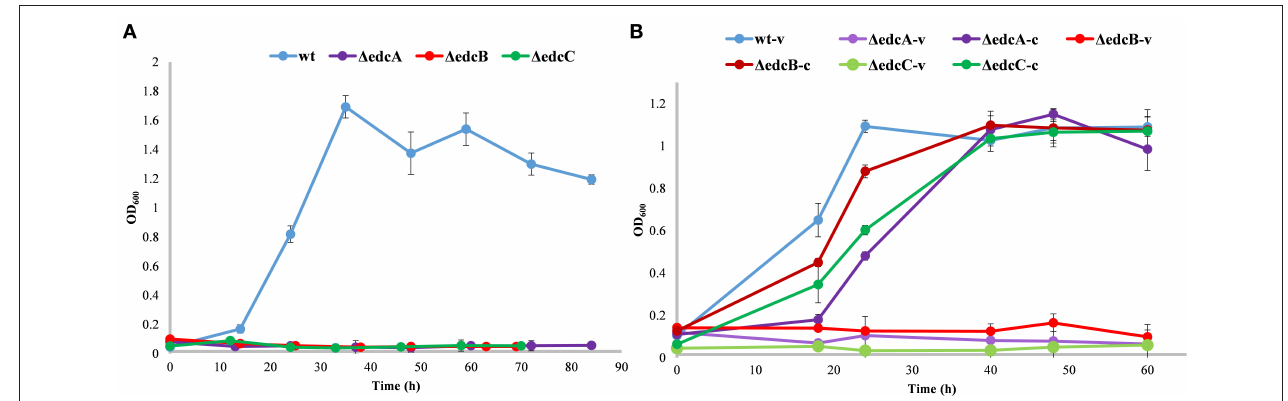
FIGURE 5 | Growth curves (OD 600 ) in minimal medium M63 supplemented with 2mM E2. (A) Growth of N. tardaugens NBRC 16725 (blue), 1 edcA (purple), 1 edcB (red), and 1 edcC (green). (B) Growth of N. tardaugens NBRC 16725 and the mutant strains with pSEVA23PlexA, (-v), and complemented with the corresponding deleted gene, (-c). Data corresponding to biological triplicates and error bars show standard deviation.